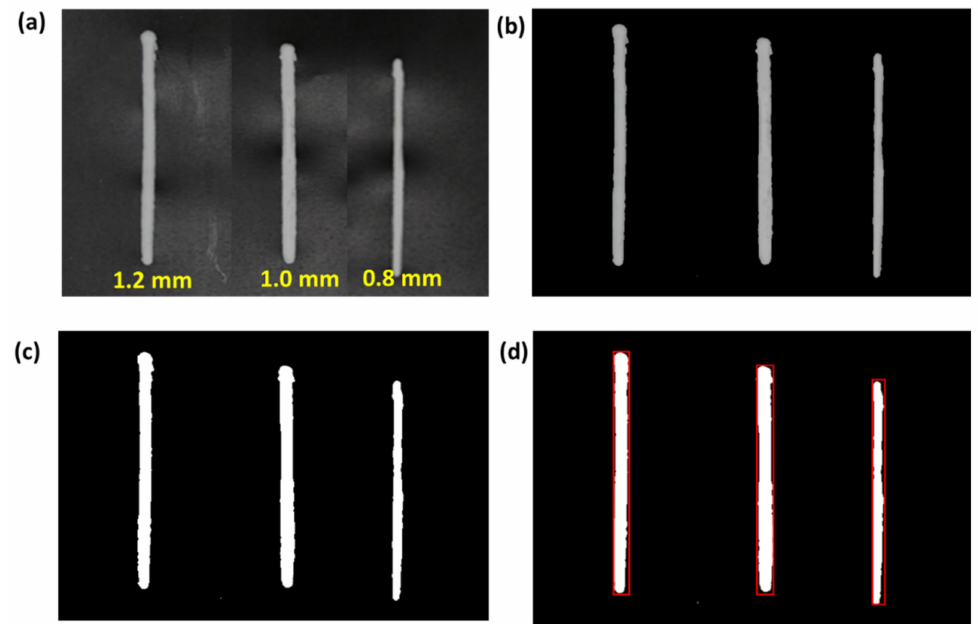
Figure 4. The image processing procedure for extruded rice paste: ( a ) frame image acquired from videotape, ( b ) background removal, ( c ) gray image generation, ( d ) bounding box